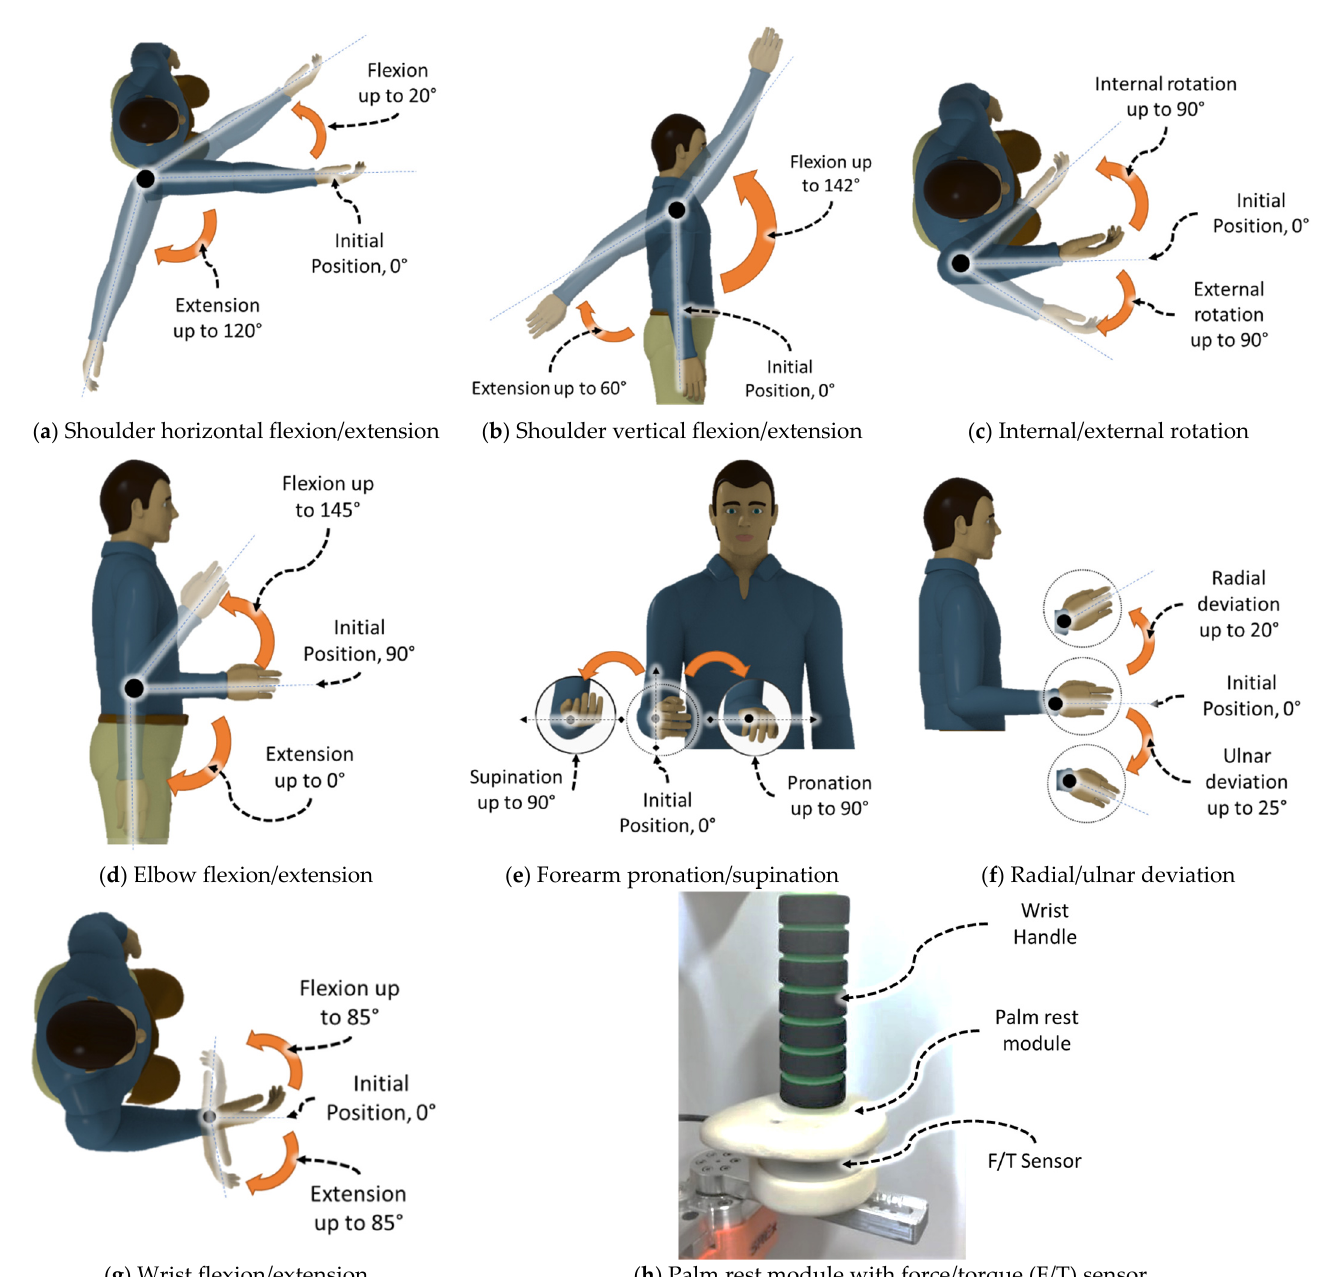
Figure 2. Workspace of SREx and associated human motions ( a – g ), ( h ) installed F/T sensor. Table 1. SREx ’s hardware